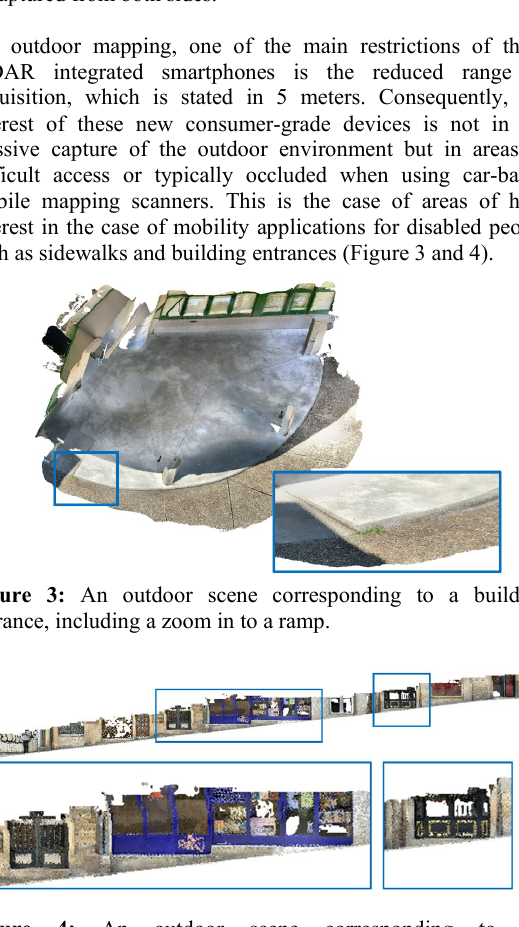
Figure 6. 3D reference model created in Revit software. The ceiling has been removed for visibility purposes.